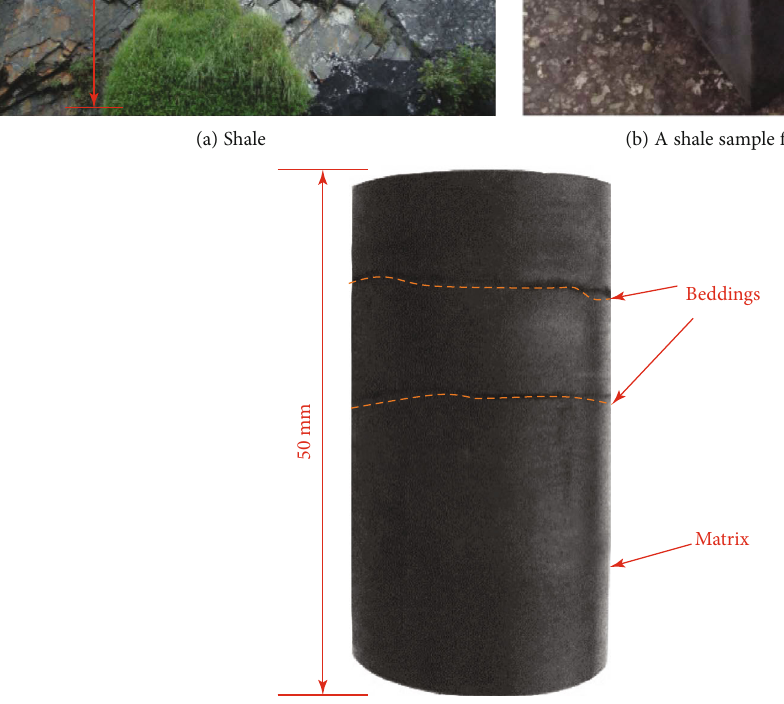
Figure 1: Distributions of natural fractures in shales [33].